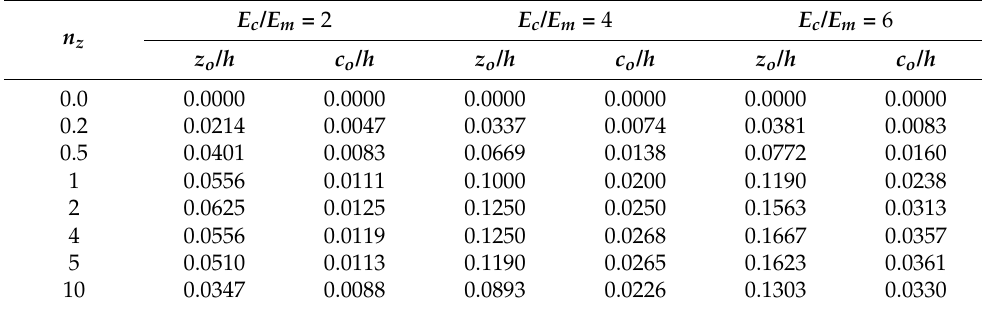
Table 2. Maximum values of z 0 / h and c 0 / h at different n z and E c / E m ratios ( n x = 1 )